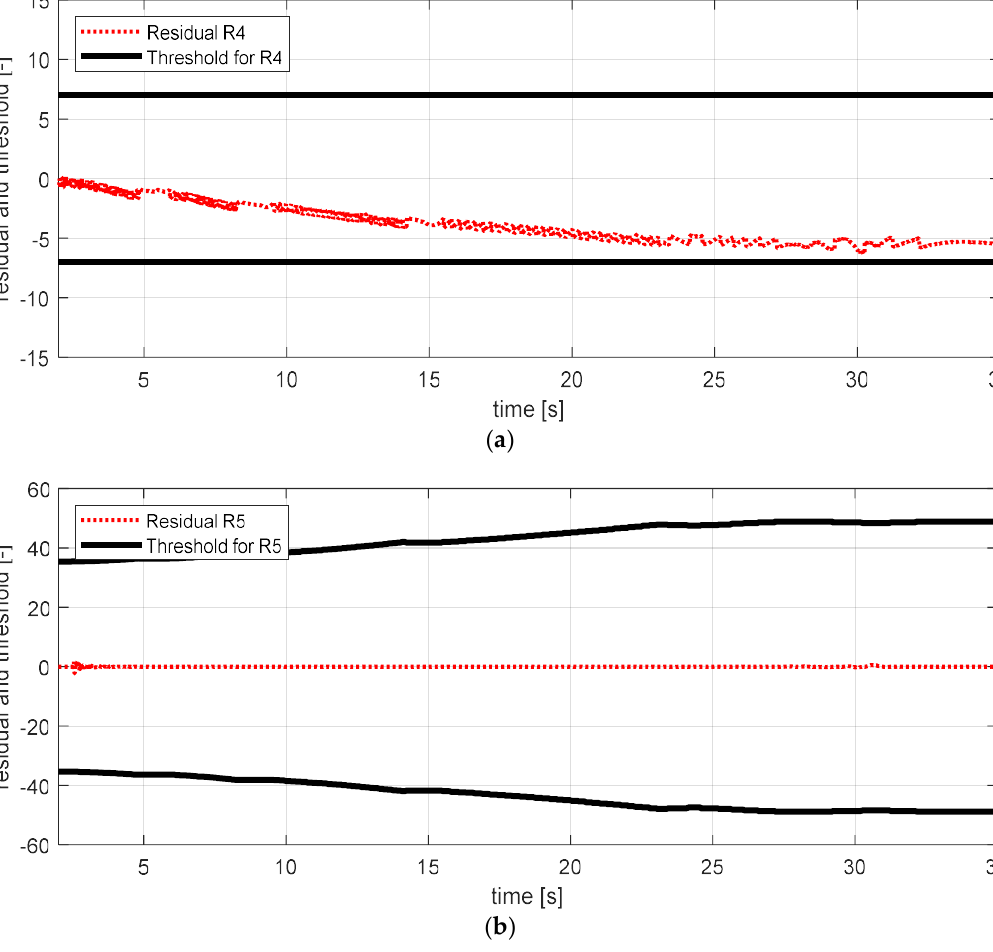
Figure 25. FDI simulation result for wheel angular speed sensor—rr (normal). ( a ) Residual 4 and threshold; ( b ) residual 5 and threshold.